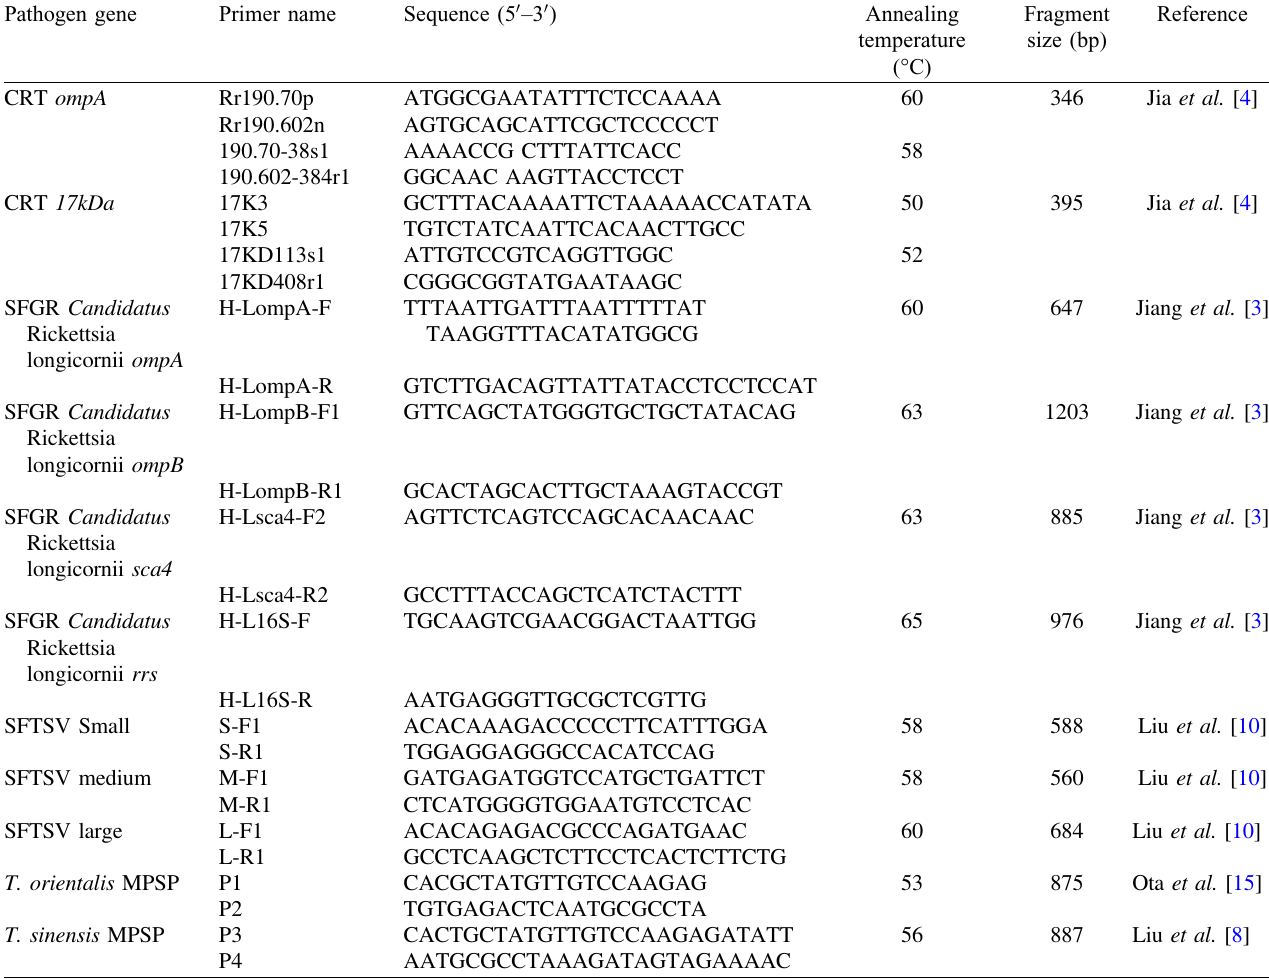
Table 1. Primer sequences used for the gene ampli fi cation of different pathogens.